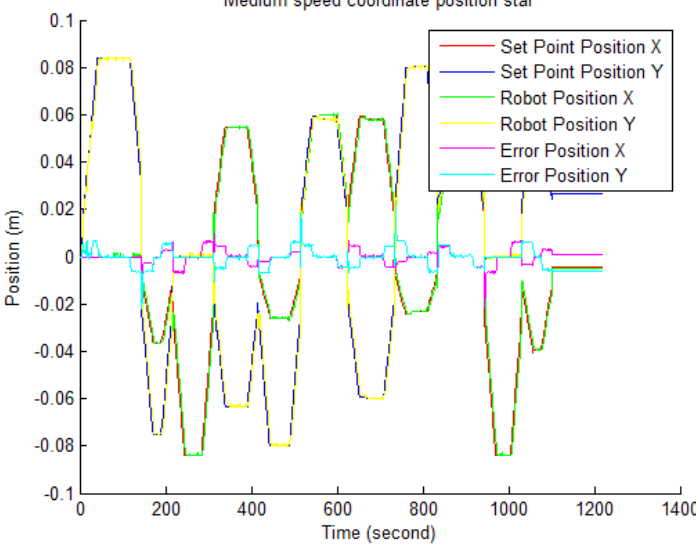
Figure 26. Position coordinates for medium